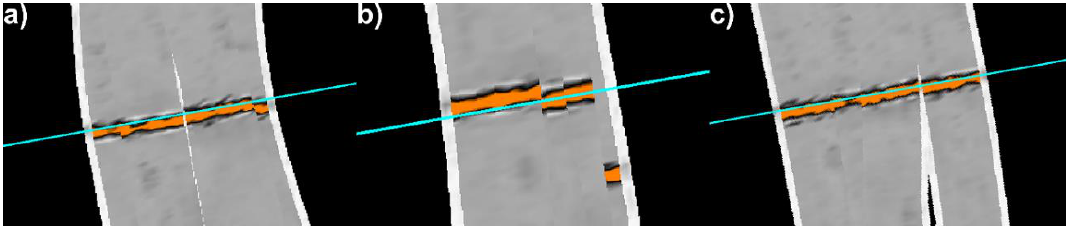
Figure 9. Resulting C-scans for parallel passes positioned with the use of: ( a ) GPS PPS ( b ) GPS and ( c ) the total station—with the scanned drainage grille in the background.